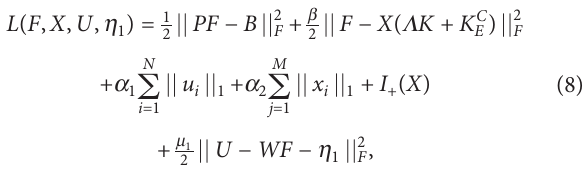
Algorithm 1 ADMM algorithm Eq.